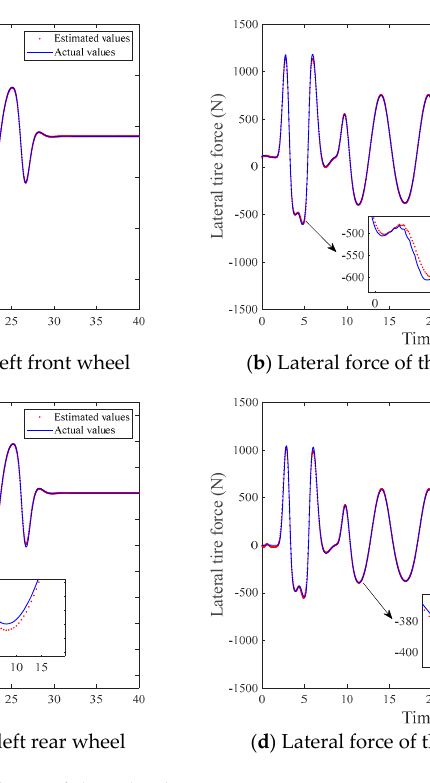
Figure 12. The longitudinal tire force of the wheels.